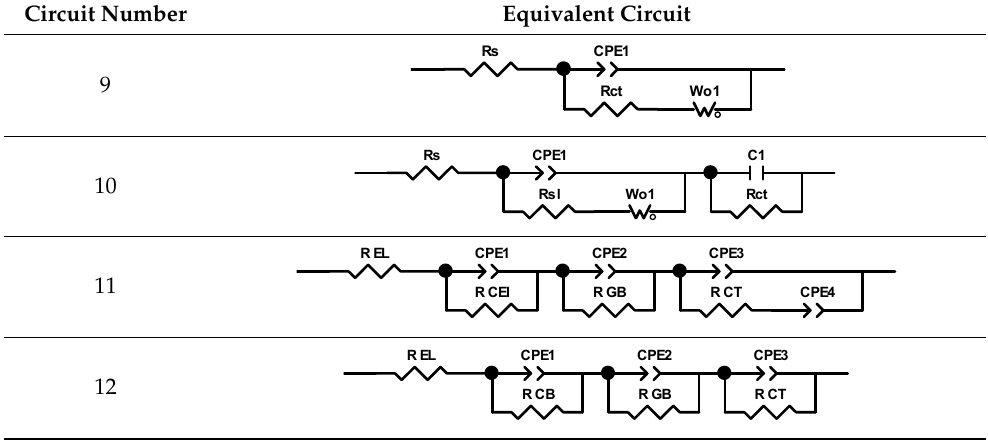
Table A2. Cont. Circuit Number Equivalent